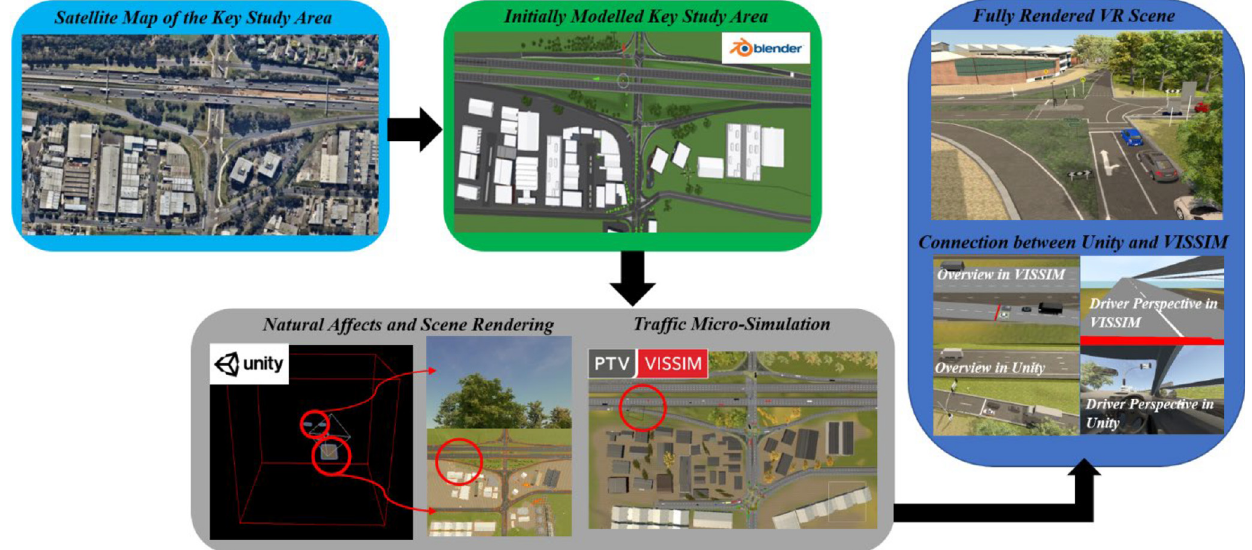
Figure 1 The development procedure of the simulation